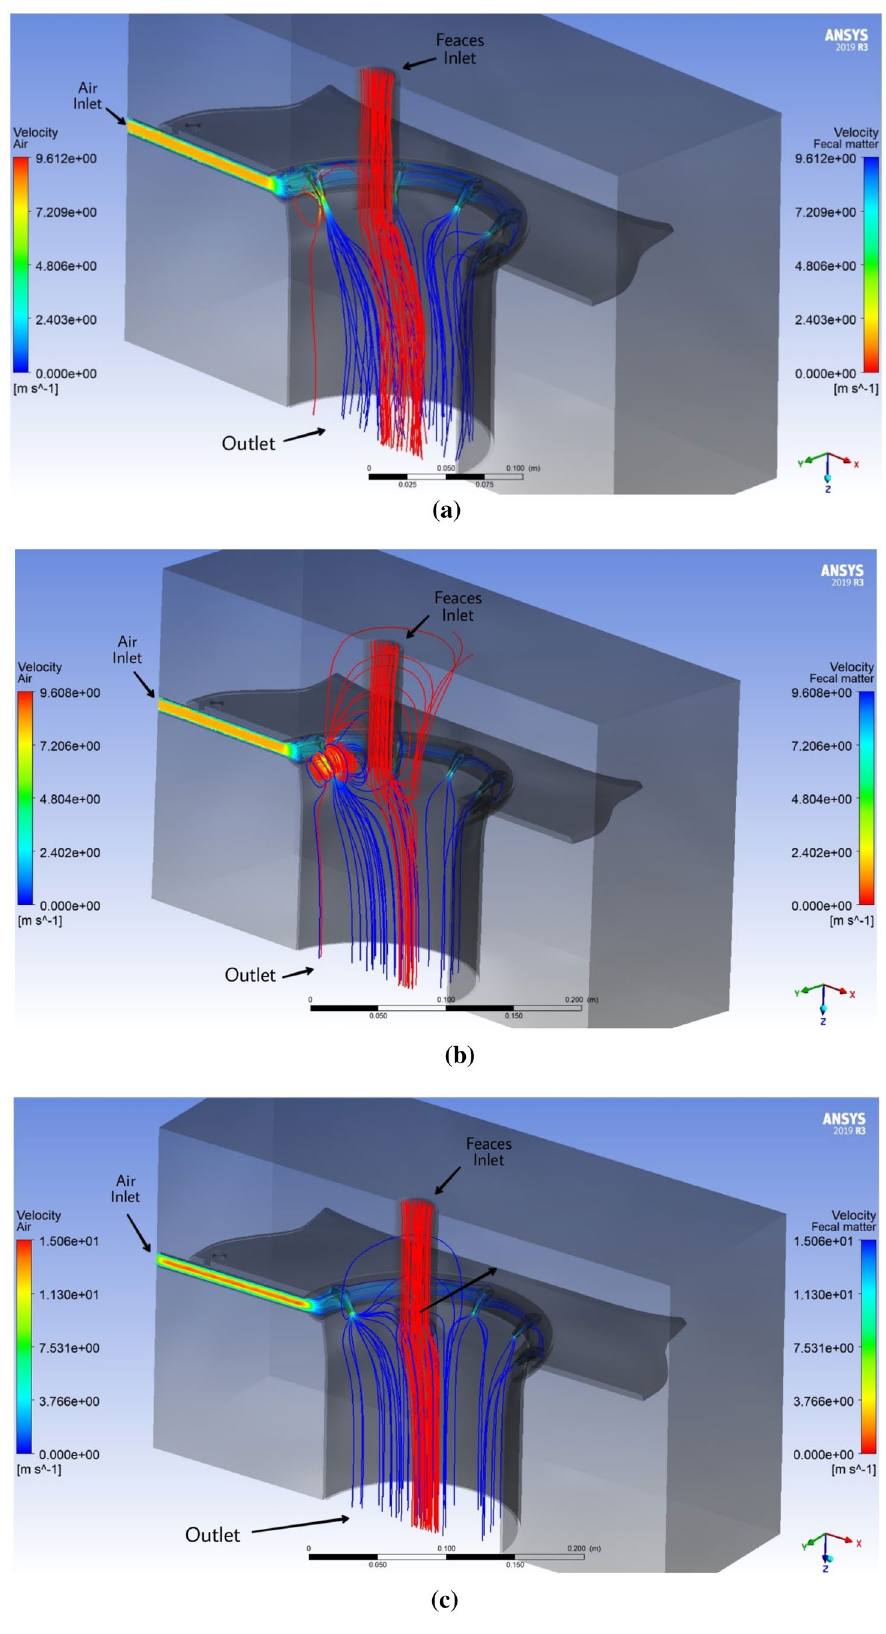
Fig. 17 The air flow simula- tions through nozzles provided with the seat (40 cm wide and 40 cm long) are done for three different conditions such as a for Mars gravity (3.721 m/s 2 ), b for the Moon gravity (1.62 m/ s 2 ), c for the zero- or micrograv- ity i.e., the space gravity. The fecal matters are flushed with air at a high velocity around 8 m/s towards the fecal waste storage. The CFD analyses are carried out to study flow patterns of (i) air through the nozzles of AFFS, and (ii) fecal